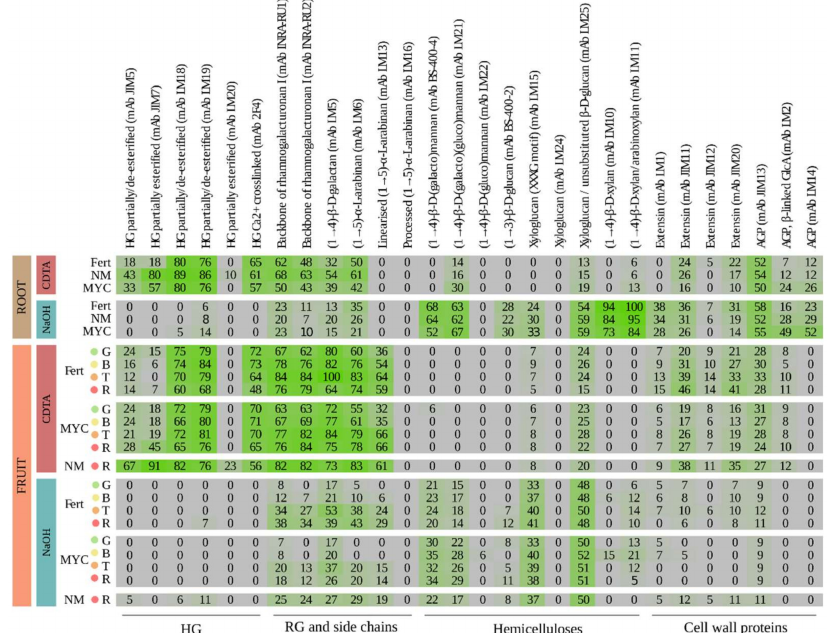
Figure 1. CoMPP (comprehensive microarray polymer profiling) analysis of CDTA- (Cyclohexane Diamine Tetraacetic Acid) and NaOH-extracted cell-wall fractions from tomato root and fruit tissues under mycorrhizal (MYC), fertilized (FERT) and non-mycorrhizal (NM) conditions. The heatmap shows the relative abundance of the epitopes. Fruits were analyzed at four different ripening stages: “mature green” (G), “breaker” (B), “turning” (T), and “red” (R). The highest signal in the data set was set to 100, and all of the other values were normalized accordingly. A cut-off of 5 was introduced.